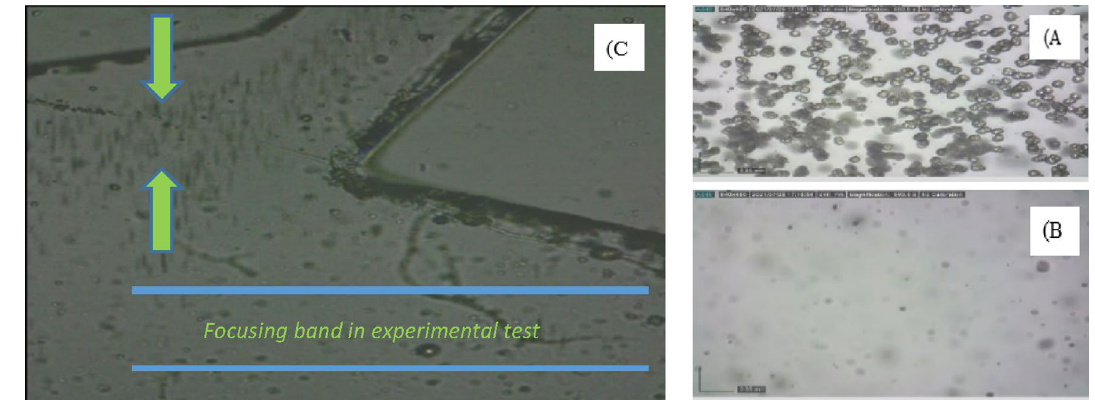
Figure 11. ( A ) and ( B) show the outputs associated with larger and smaller particles, respectively. ( C ) Online trajectory of high concentration cell samples at golden flow